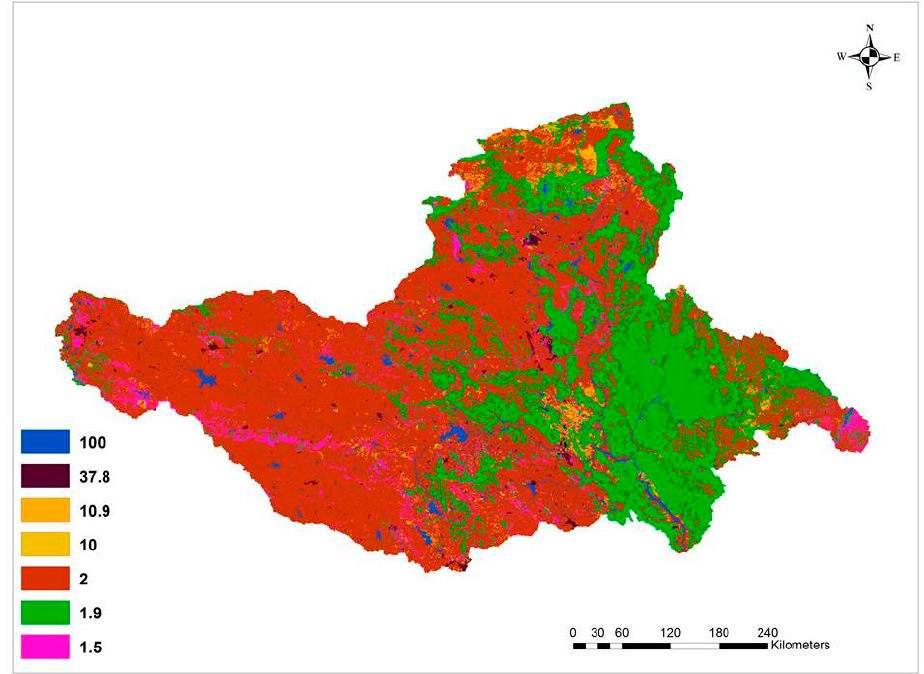
Table 7. The percent imperviousness of the study area for the corresponding land-use classes.